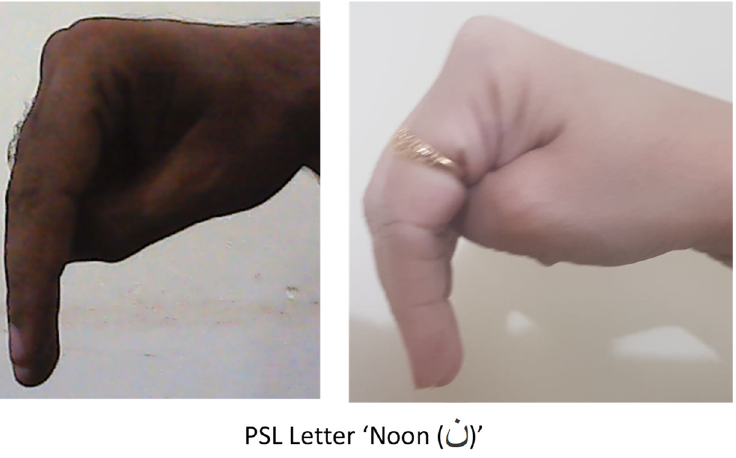
Figure 22. Detecting other objects—ring.